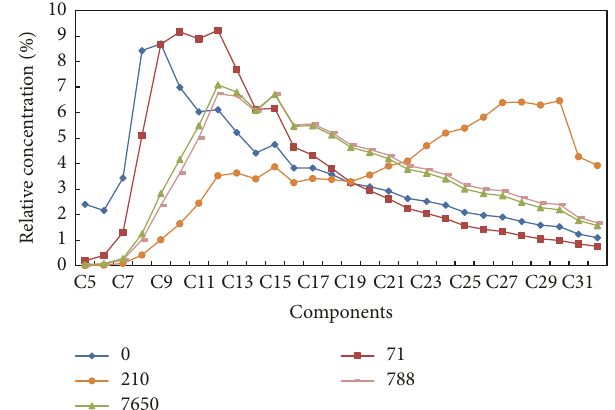
Figure 4: Relative concentration of produced oil at different time in the heterogeneous model.